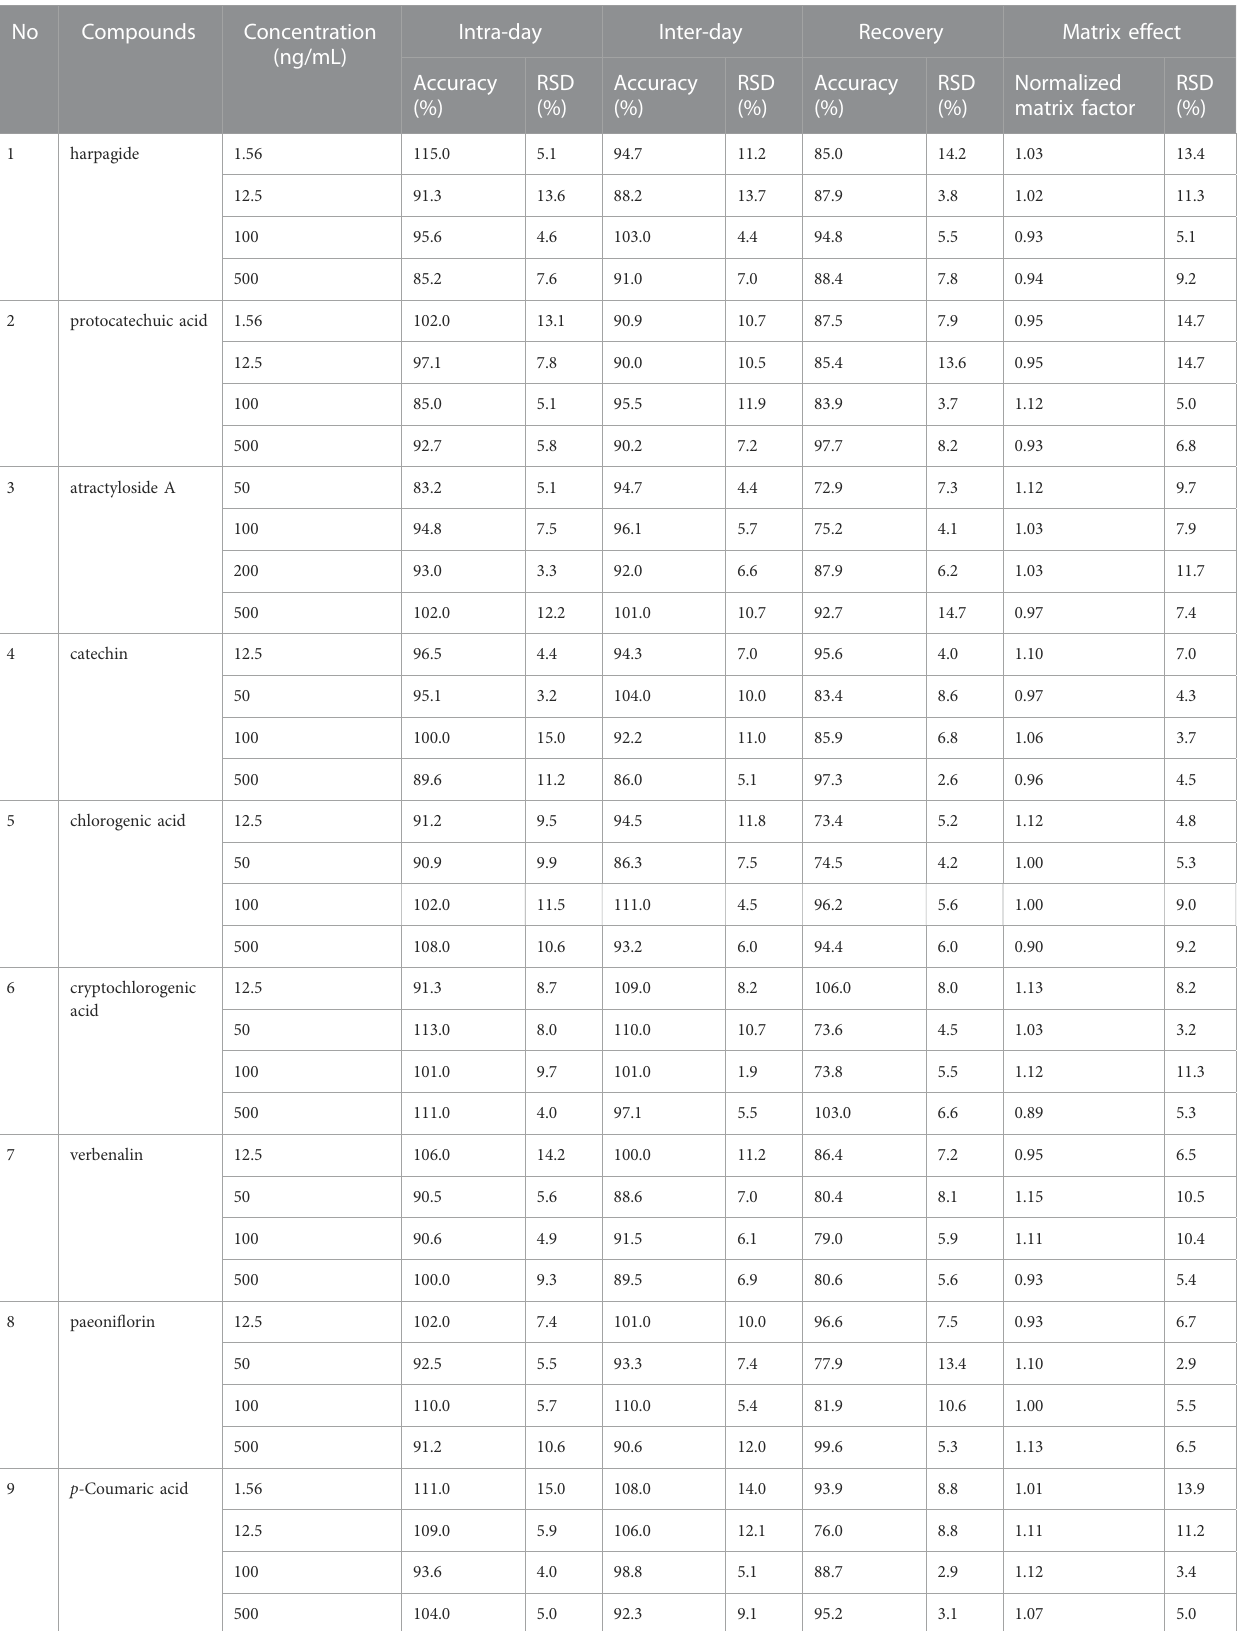
TABLE 1 Extraction recovery, matrix effect and precision of 33 analytes from QJYQ and 3 ISs. No Compounds Concentration